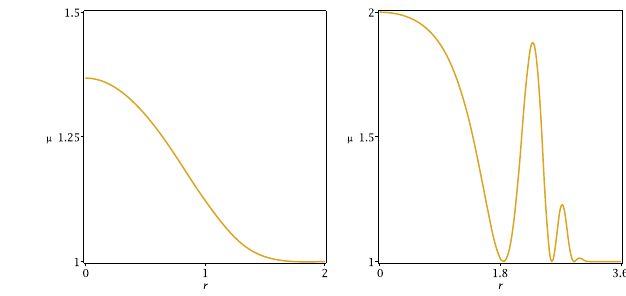
Fig. 12 Permeability μ 3 ( r ) from Eq. (30), for n 1 = 1. In the left, we depict μ 3 ( r ) when ϕ 2 is a vacuum solution. In the right, we show the form of this permeability for a symmetric defect with n 2 = 10